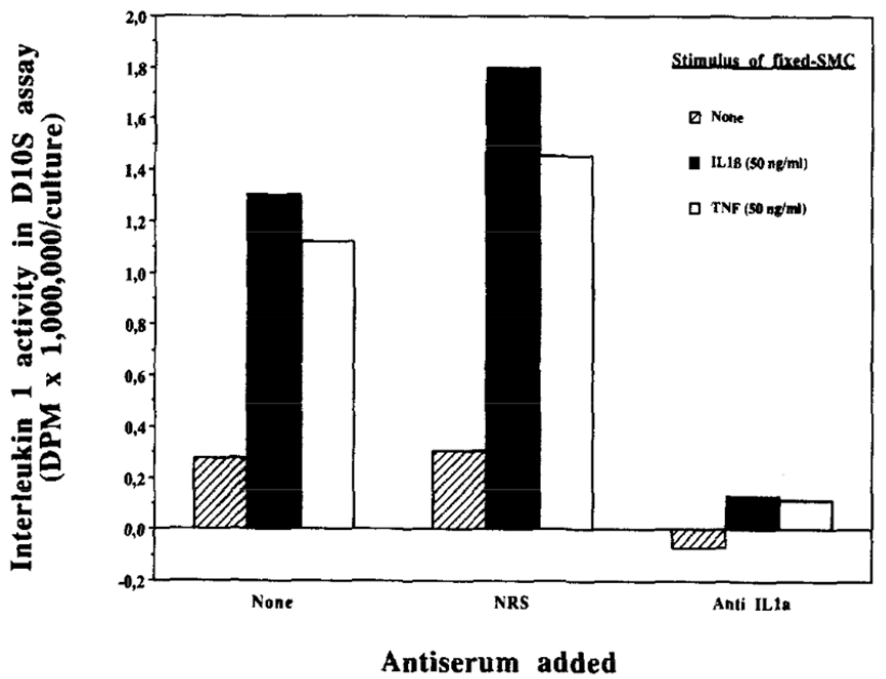
Figure 7. IL-1 α activates smooth muscle cells via juxtacrine signaling. Smooth muscle cell monolayers were lightly fixed with paraformaldehyde after stimulation with IL-1 β or tumor necrosis factor. A responder layer of smooth muscle cells was seeded above the fixed smooth muscle cells. Thymidine incorporation into D10S cells assessed IL-1 activity. The responder cells also elaborated IL-6 in other experiments not shown. From Exp Cell Res 198:283-290;1992.